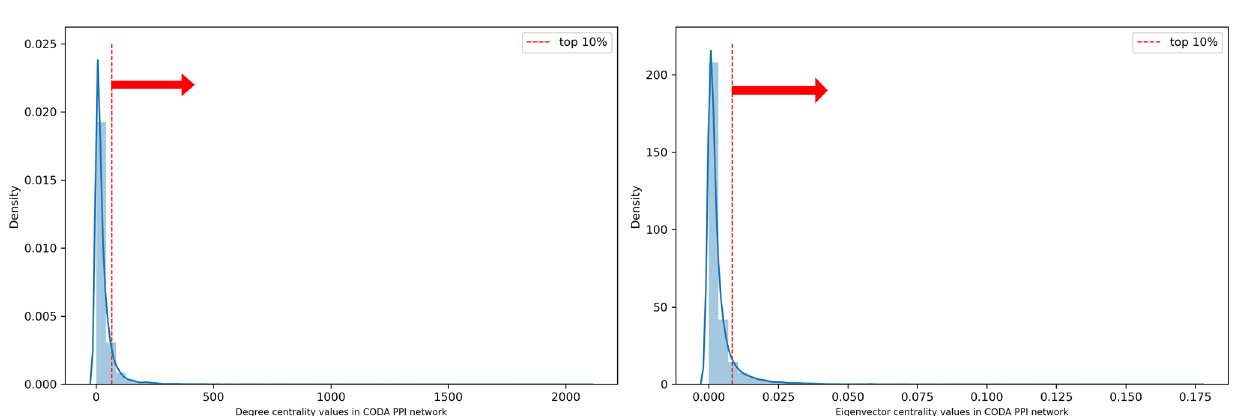
Figure 6. Distribution of centralities of all nodes in protein–protein interaction network. (Left) shows distribution of degree centrality and, (Right) shows distribution of eigenvector